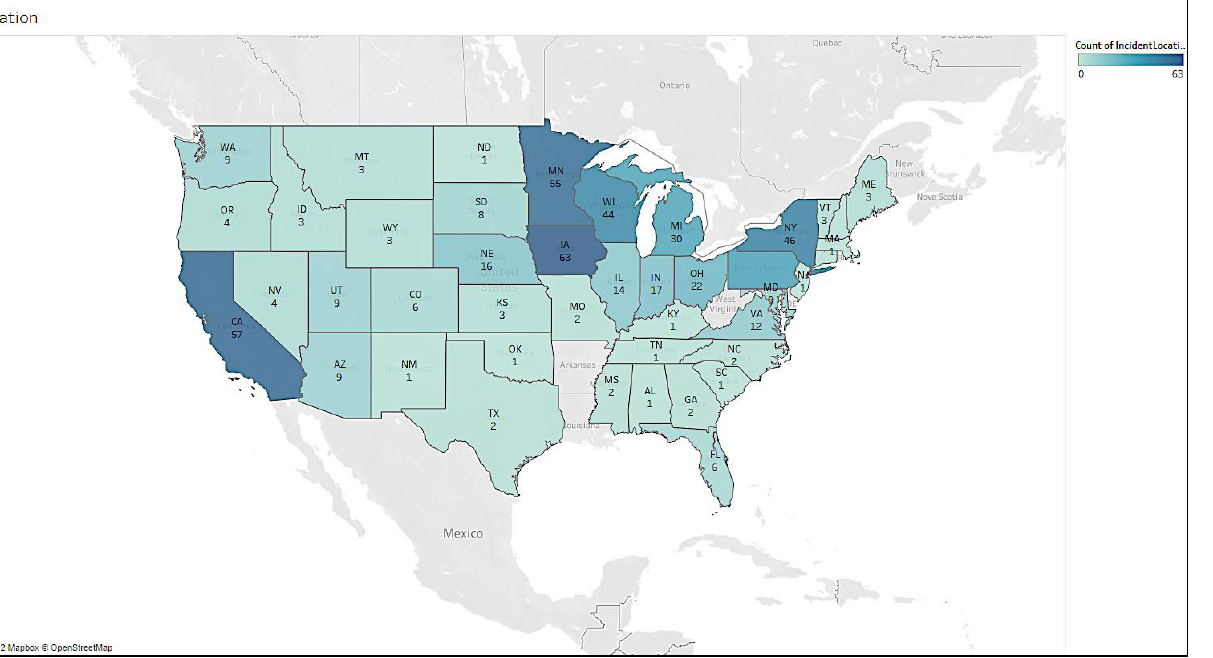
Figure 8. Dashboard software displays agricultural waste injury and fatality data.